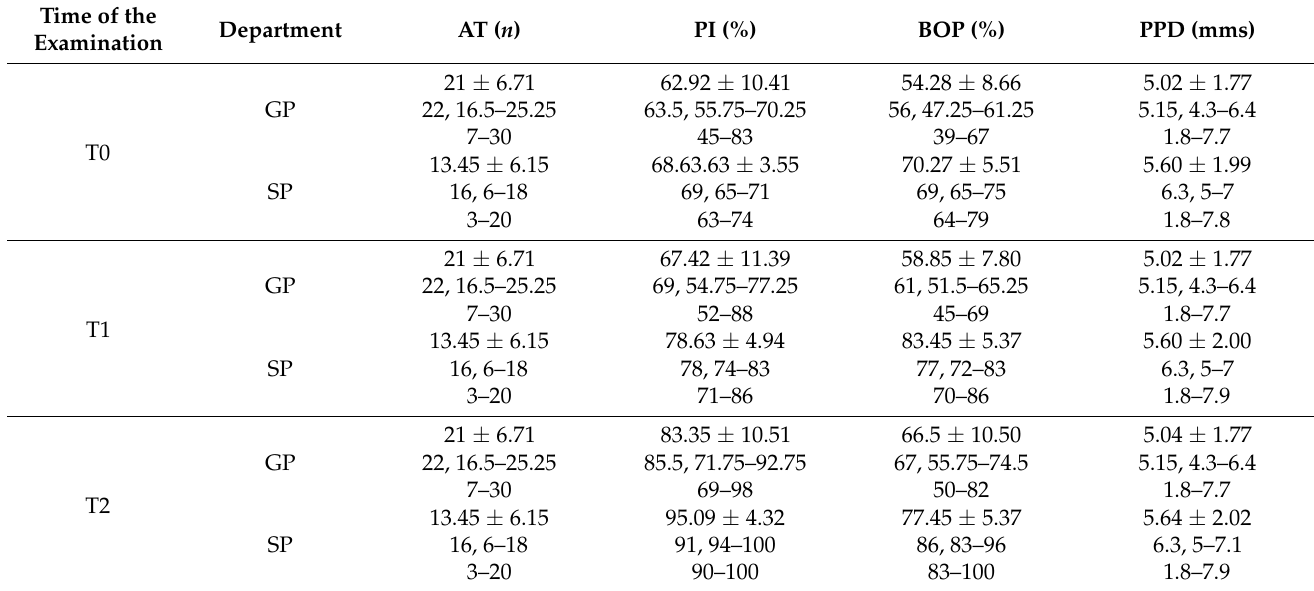
Table 2. Periodontal parameters (mean ± standard deviation, median, interquartile range,